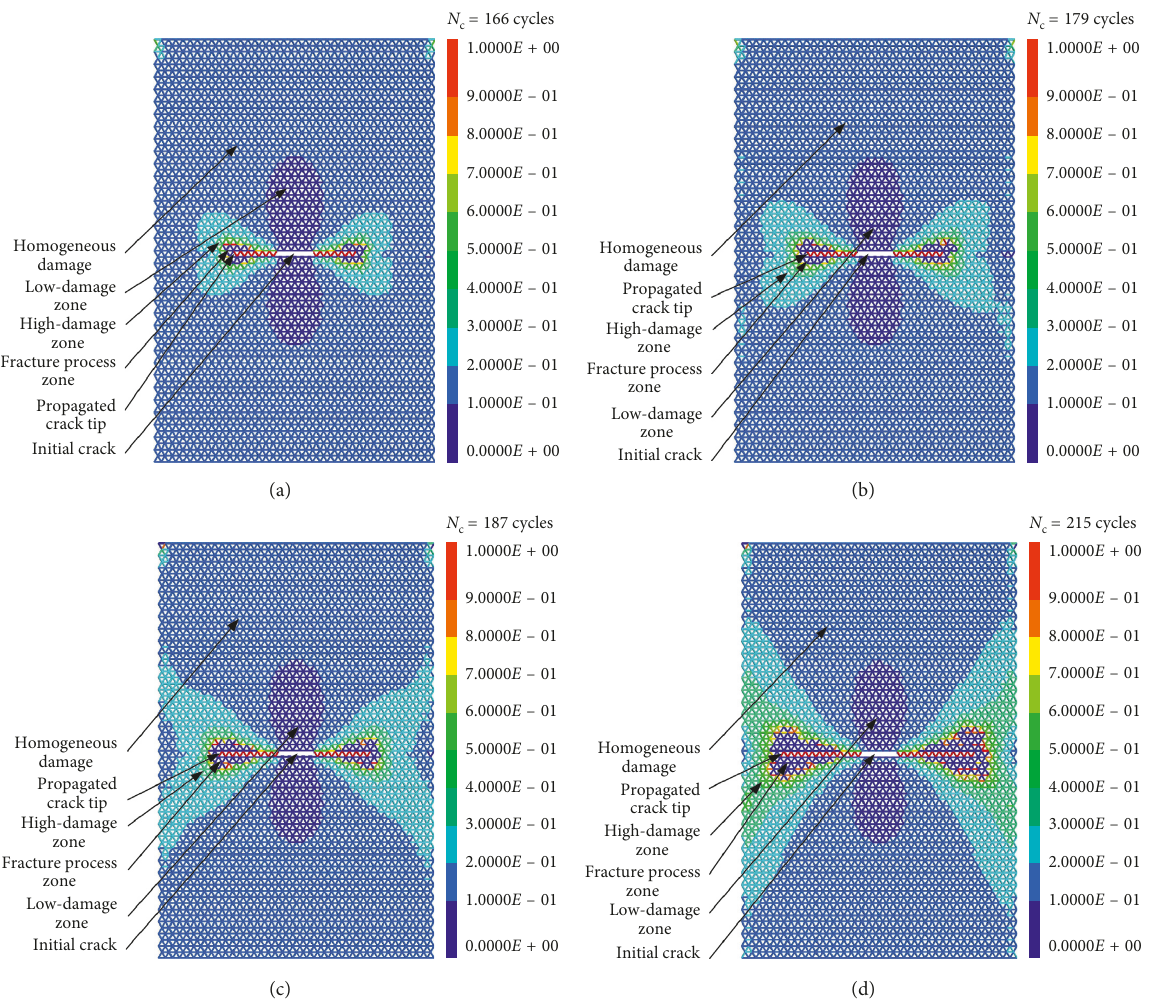
Figure 19: Damage distribution and crack propagation of a precracked plate with the initial crack length a (c) 187, and (d) 215 fatigue loading